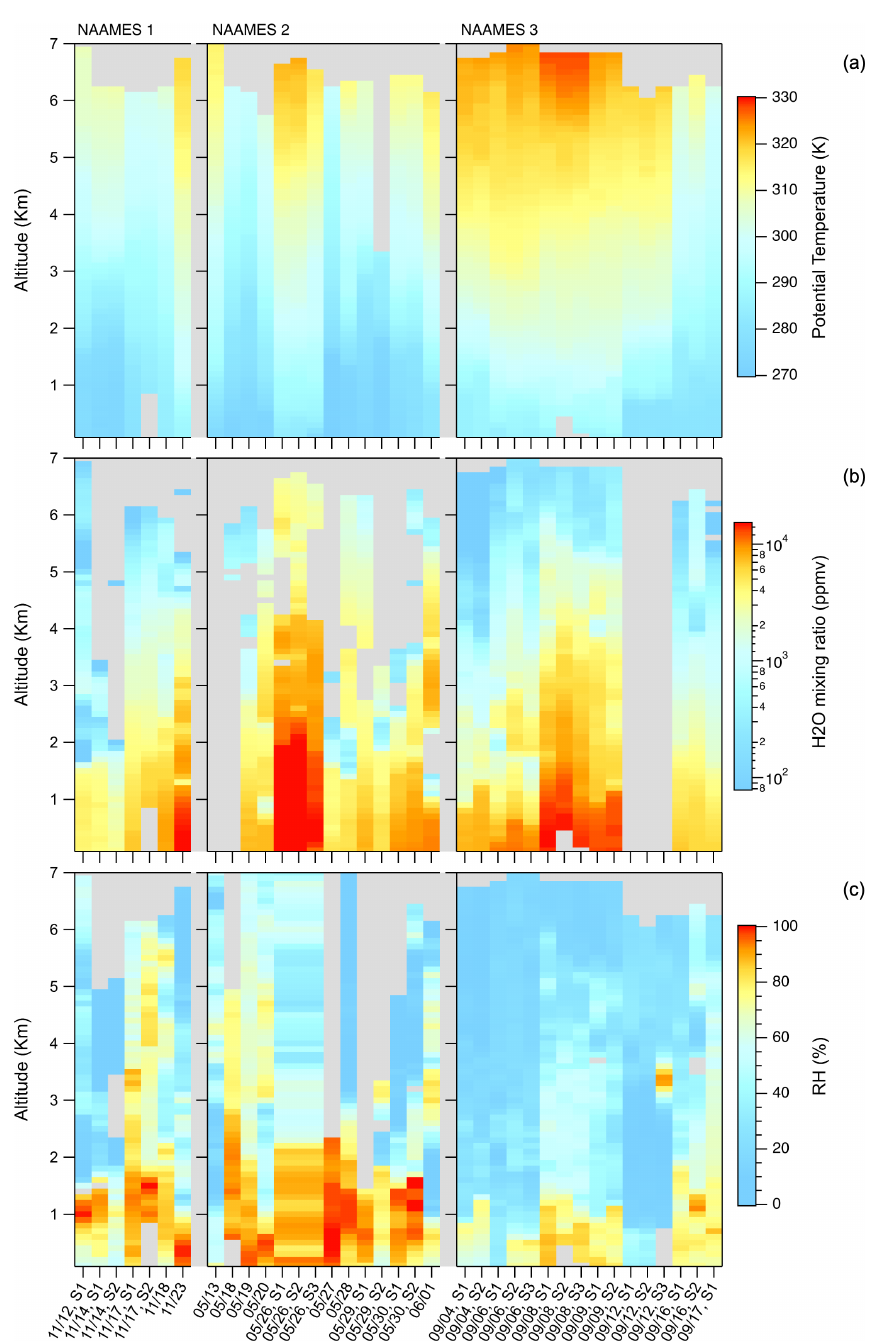
Figure 1. Vertical profiles of potential temperature (a) , H 2 O mixing ratio (b) , and relative humidity (c) during NAAMES-1, NAAMES-2, and NAAMES-3. Relative humidity measurements from the meteorological sensor package are not available for the spirals conducted on 26 May 2016; therefore, RH measurements were collected via radiosonde ship launch on 26 May 2016 at